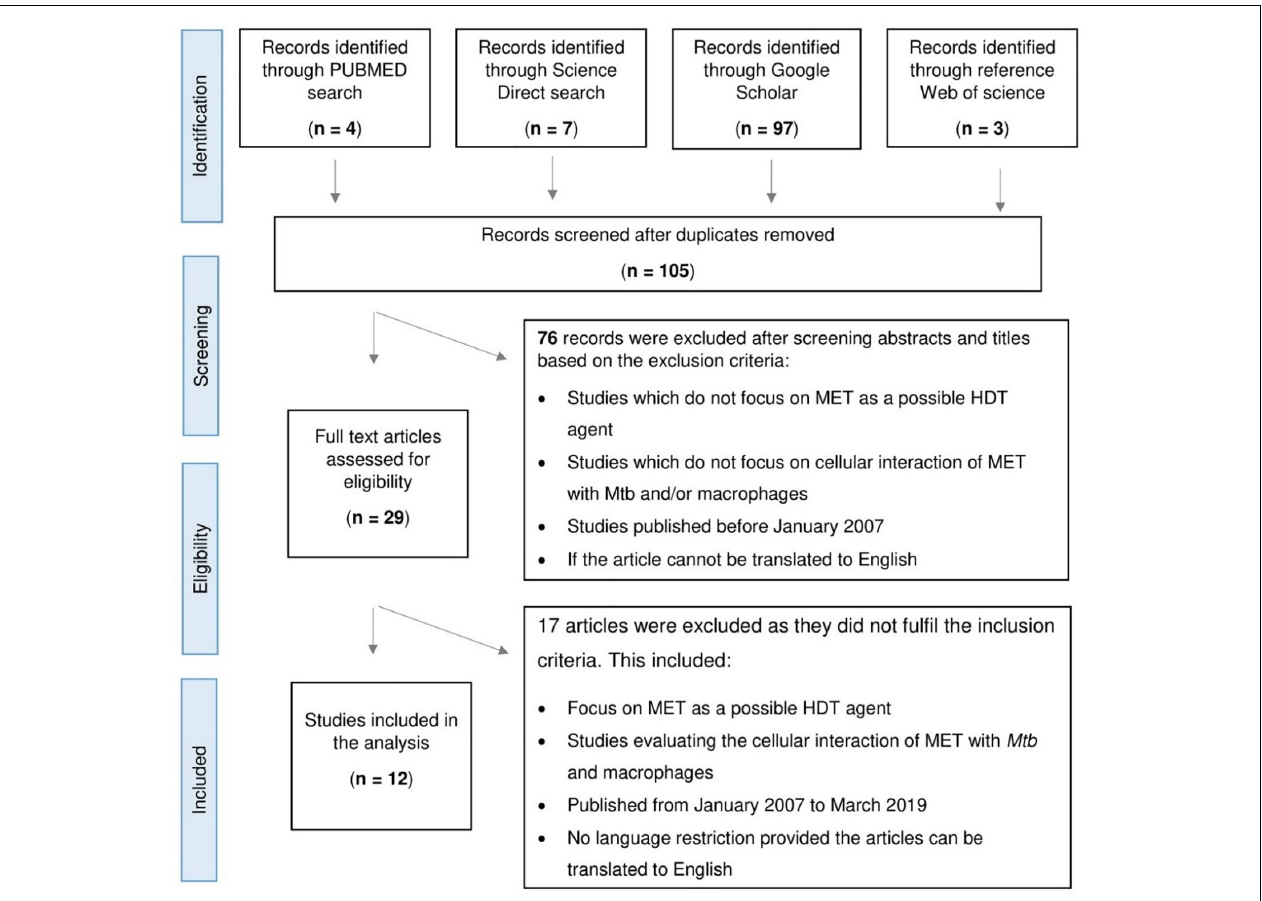
FIGURE 1 | Flowchart depicting the process of article selection for scoping study assessing the role of Metformin (MET) in